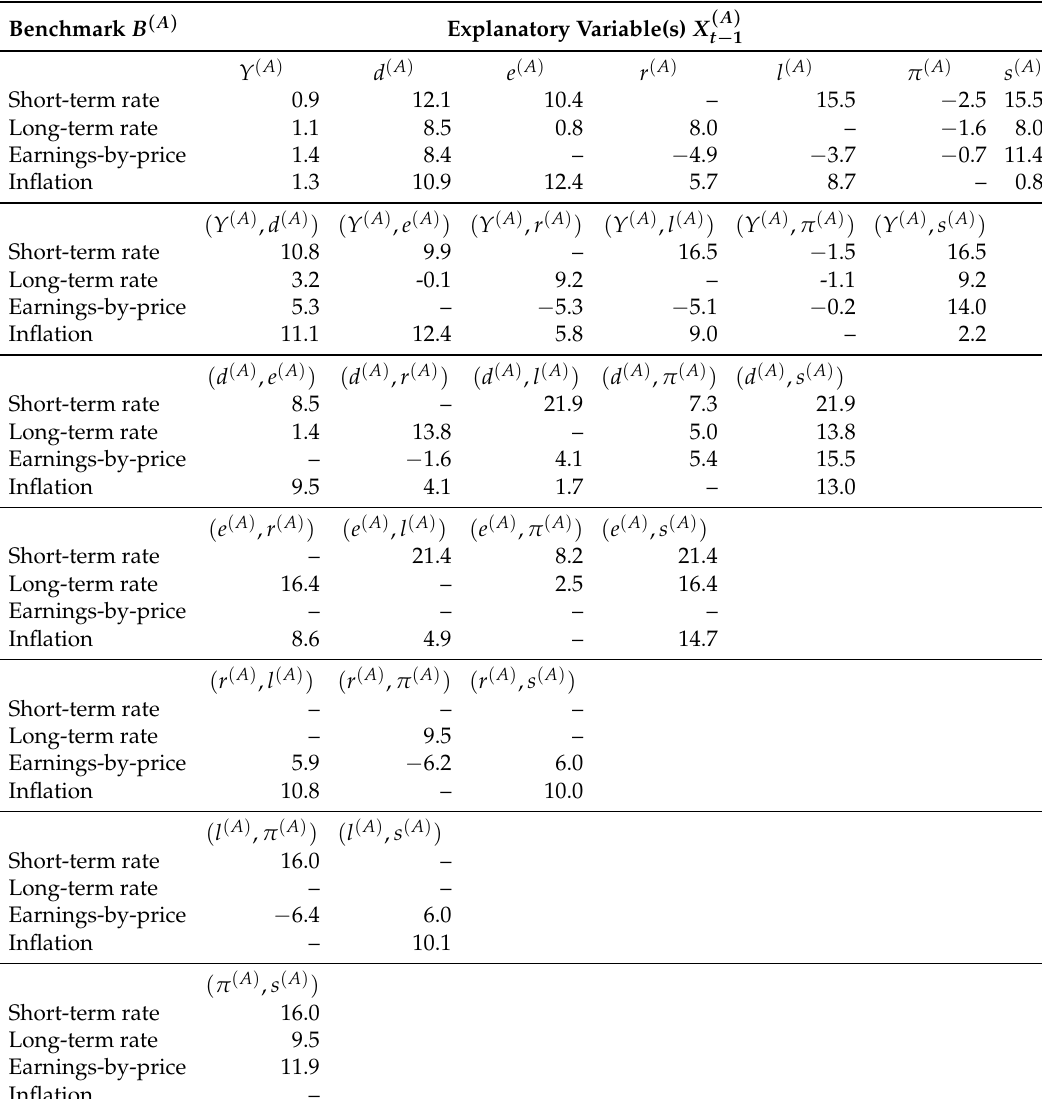
Table 5. Predictive power measured by R 2 benchmarking